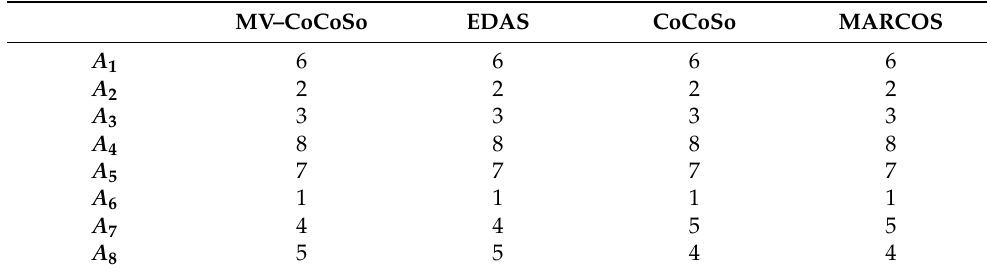
Table 13. Options prioritization using four MCDM methods.